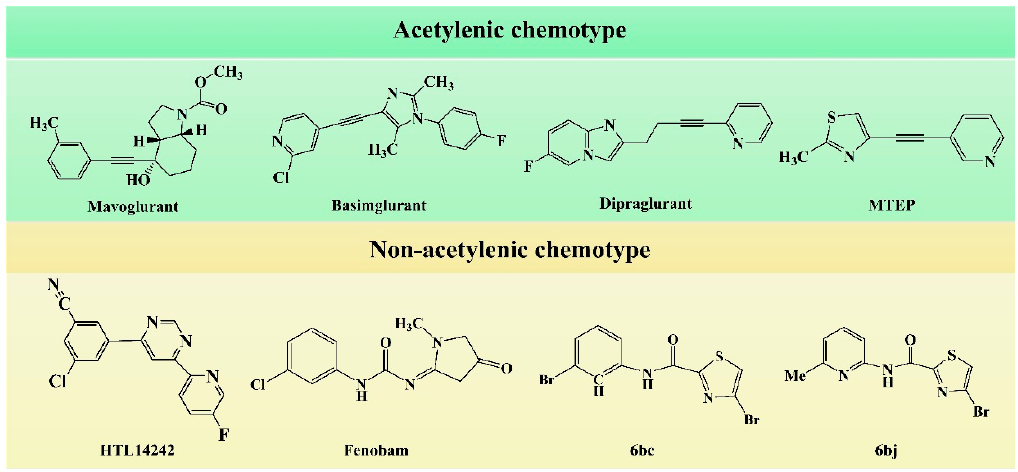
Figure 8. Structure of eight known mGluR5 negative allosteric modulators (NAMs) that have entered and are about to enter clinical trials. Table 4. Interaction features of representative mGluR5